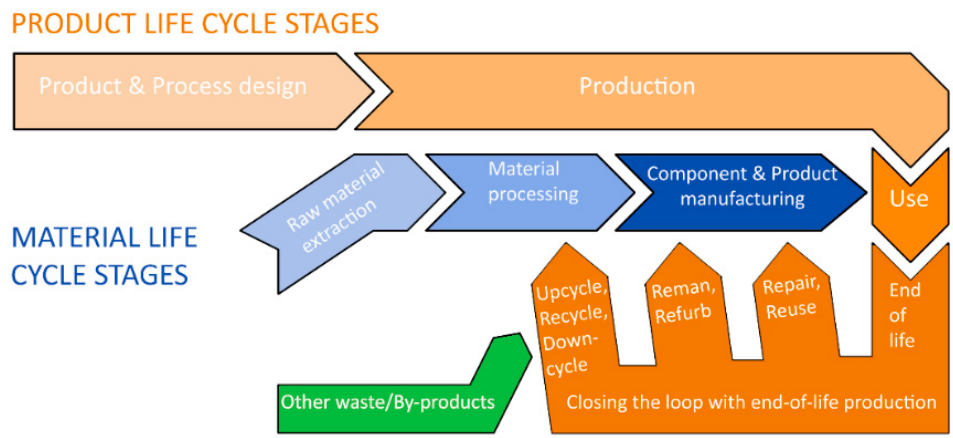
Figure 8. Product and material life cycle stages [123] .